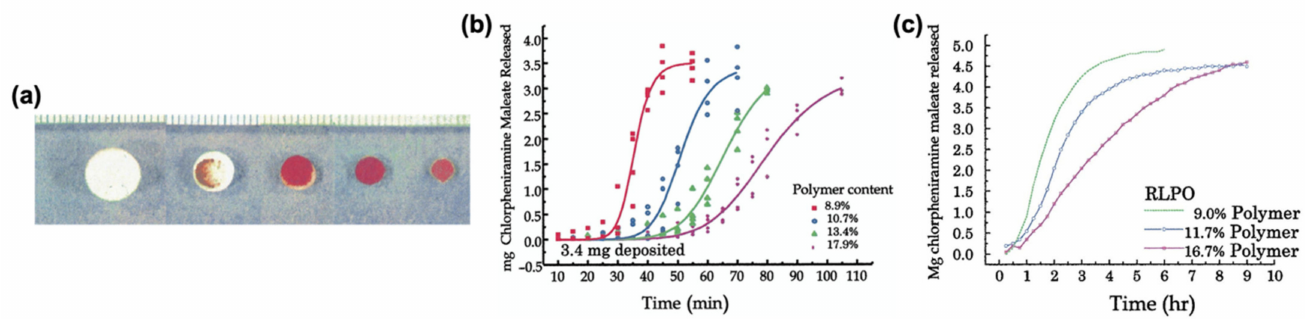
Figure 9. ( a ) BJ-printed Eudragit tablets; drug dissolution profiles of tablets printed with ( b ) Eudragit E-100; ( c ) Eudragit RLPO. Adapted with permission from Reference [77]. Copyright 2000,